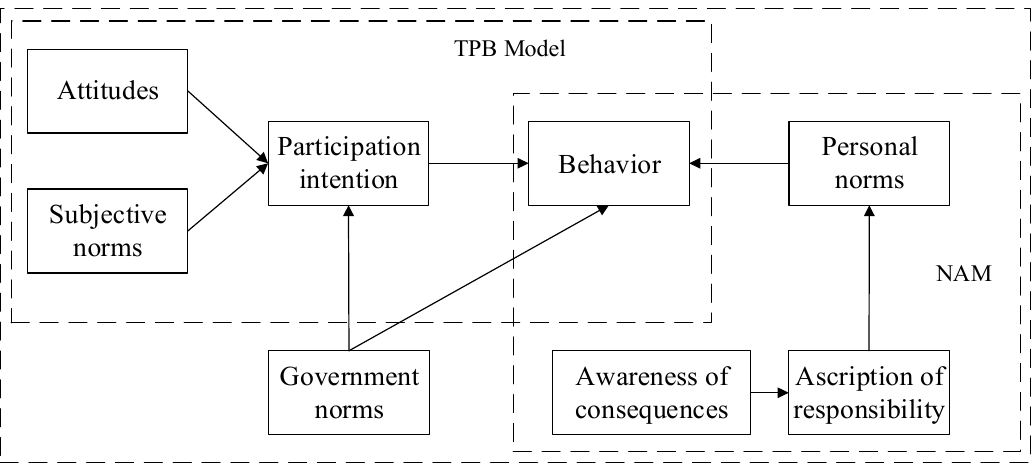
Figure 1. The integrated model of TPB ‐ NAM.